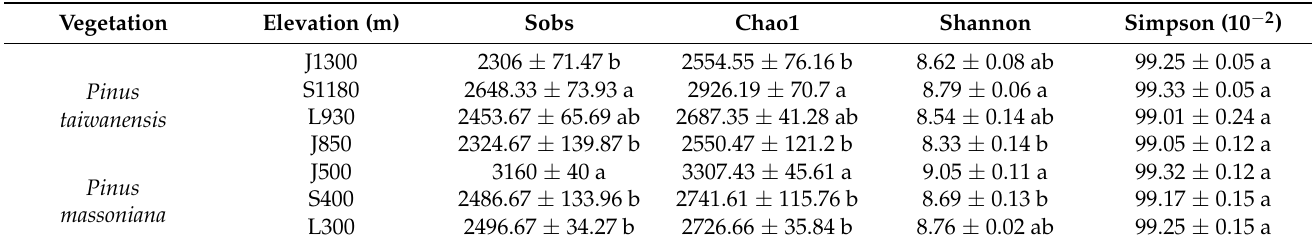
Table A1. Alpha diversity of bacterial diversity in Pinus taiwanensi and Pinus massoniana forests soils with the elevations.